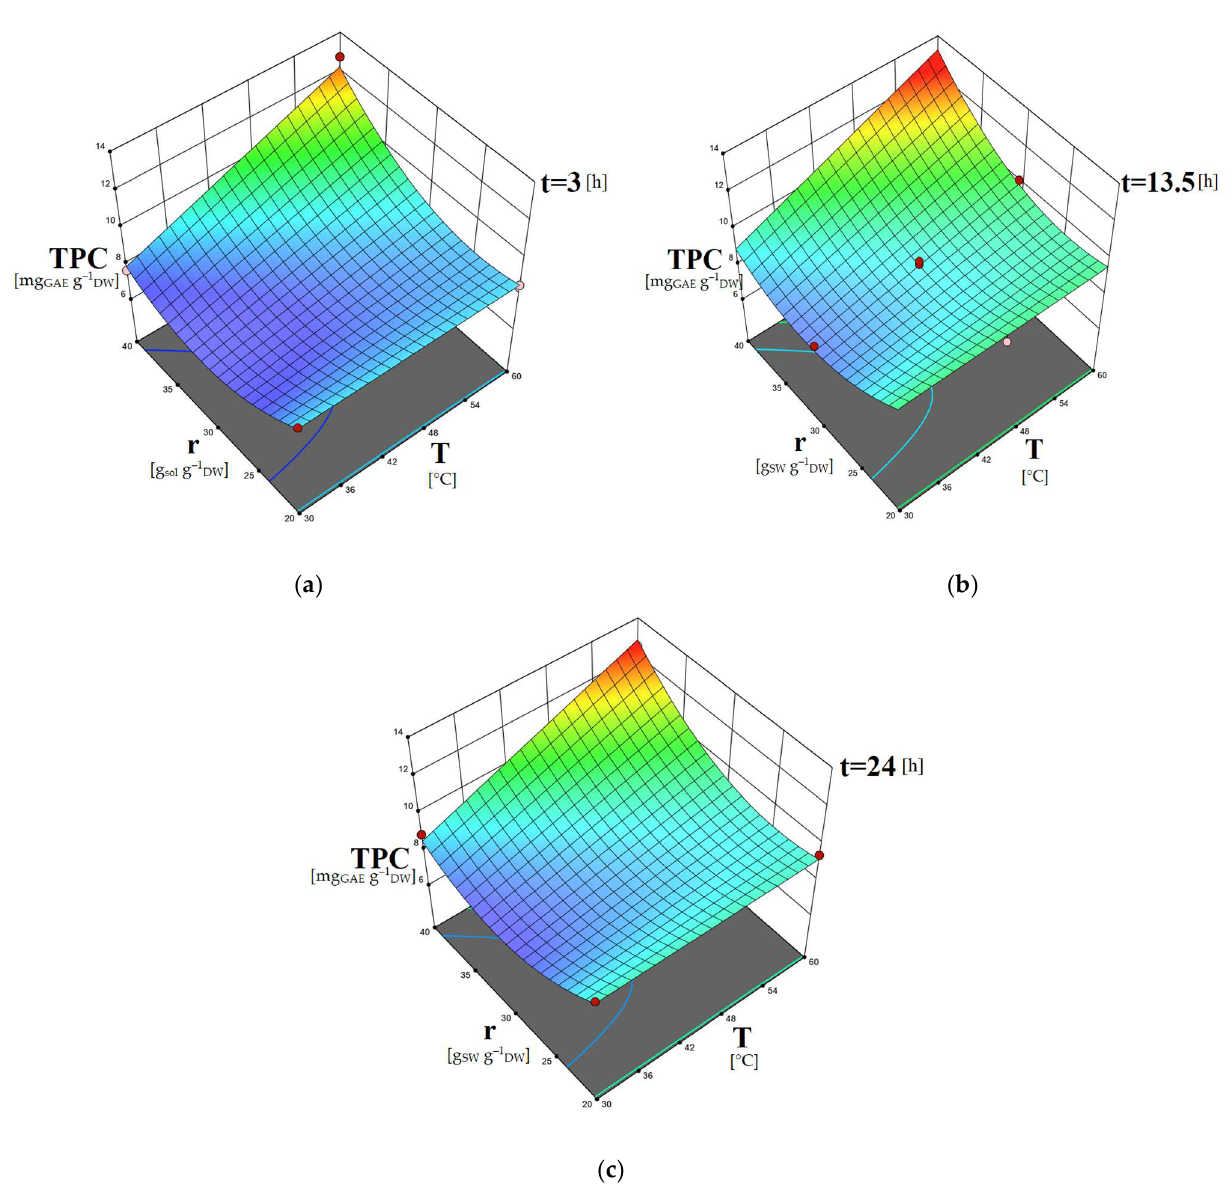
Figure 2. Three-dimensional surface plots showing the combined effects of temperature and solvent–biomass ratio ( a – c ) on TPC [mg GAE g –1 DW ] of the C. vulgaris extracts obtained using DES1/w solvent.